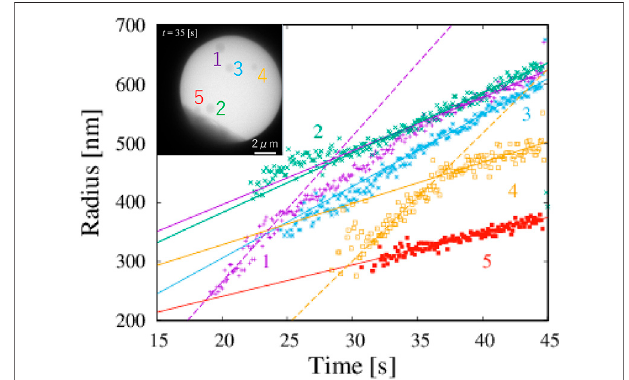
FIGURE 3 | Five NaCl particles and change in radius with time, which corresponds to Figure 1 . Solid lines are obtained by fi tting in the range 35 s < t < 45 s for each particle. Broken lines are obtained by fi tting radii less than 400 nm for particles 1 and 4. The inset shows a TEM image acquired after all fi ve particles had formed ( t (cid:2) 35 s). Numbers represents the order of appearance.